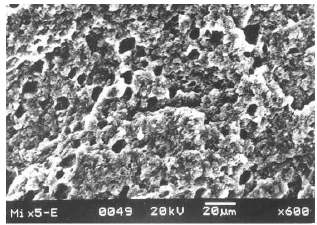
Fig.1. Scanning electron micrograph showing the uniform dispersion of silicone rubber in a TPU matrix under the optimum processing conditions.